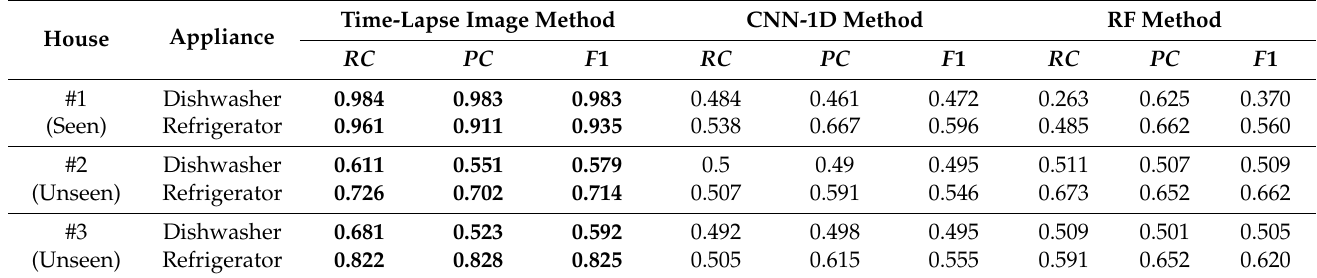
Figure 12. F 1- score of appliances between each individual approach and proposed method. Figure 12. F 1 -score of appliances between each individual approach and proposed method. Table 3. Recall ( RC )/ precision ( PC )/ F 1- score ( F 1) for the proposed and conventional deep-learning methods.